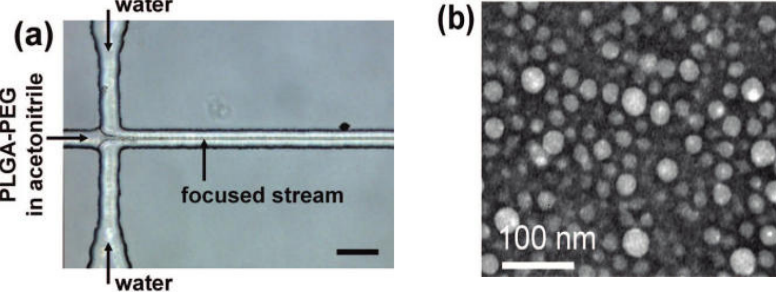
Figure 26. Nanoprecipitation by hydrodynamic flow focusing. ( a ) A microfluidic device for hydrodynamic flow focusing of polymeric nanoparticles in water, Scale bar 50 μ m; ( b ) TEM image of nanoparticles synthesized by nanoprecipitation of PLGA15K-PEG3.4K by hydrodynamic flow focusing showing spherical PLGA core-PEG corona structure of the nanoparticles